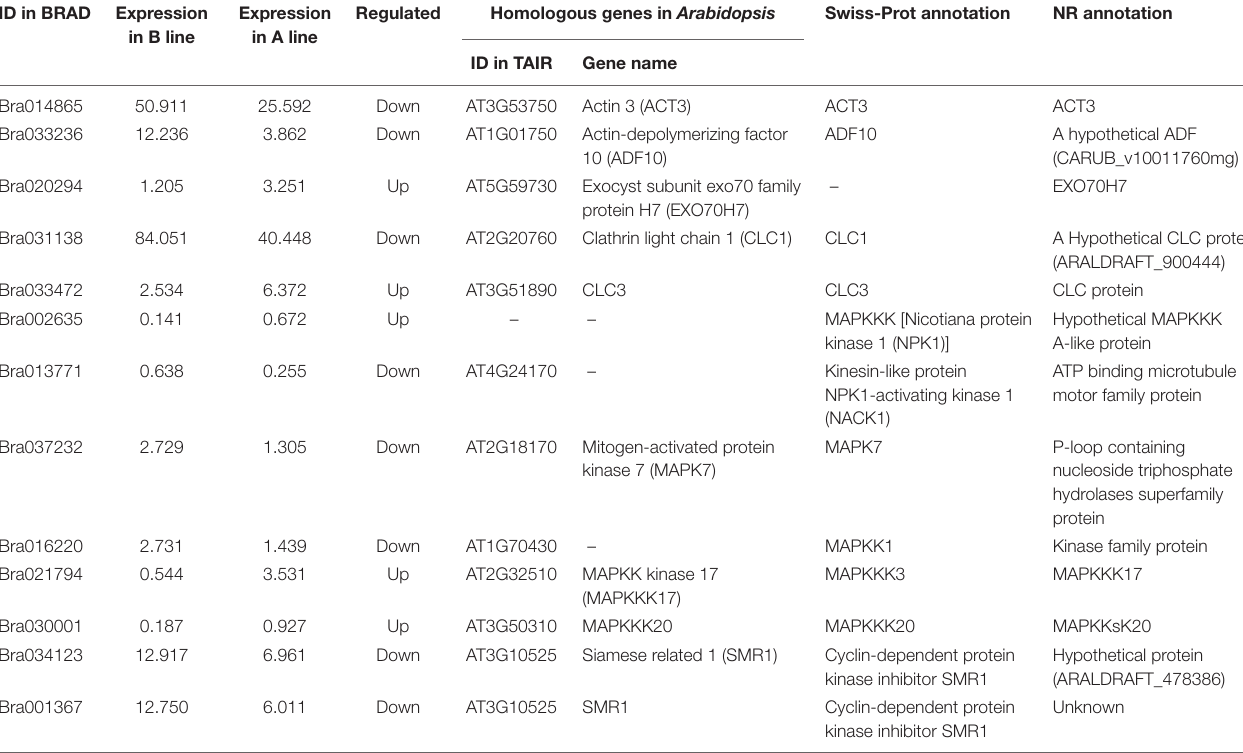
TABLE 2 | Specifically expressed genes involved in cytoplasmic cell plate formation in ‘ Bcajh97-01A ’ of Brassica campestris